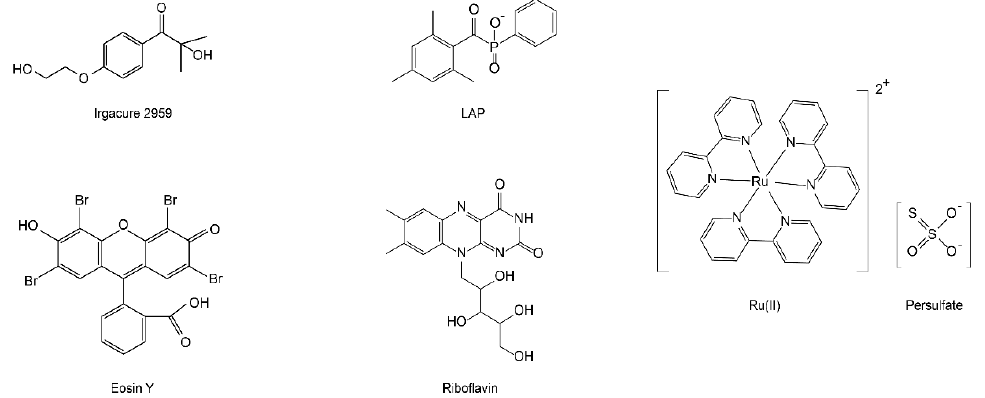
Figure 2. Common photoinitiators for crosslinking either native or chemically modified silk fibroin.